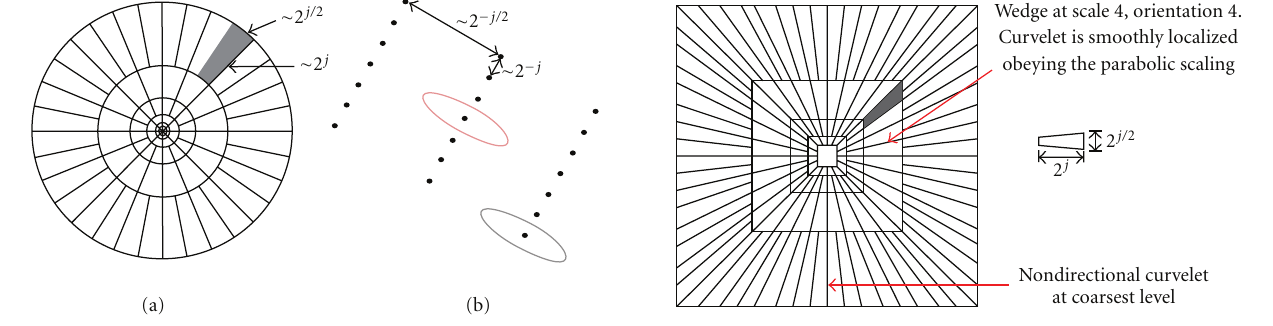
Figure 9: 5-level curvelet digital tiling of an